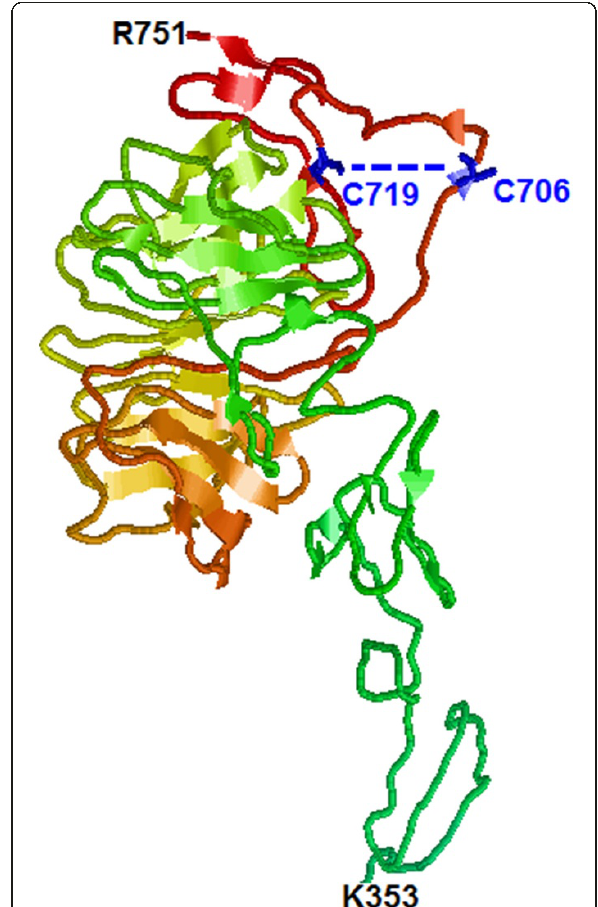
Figure 4 A model of the predicted structure of R353-K751 residues of the human VLDLR. The model was constructed using the Swiss Model program (http://swissmodel.expasy.org) with the full length sequence of the human VLDLR protein. The model has been visualized using RasMol (http://rasmol.org). According to the UniProtKP database, cysteine 706 is predicted to form a disulfide bond with cysteine 719 (Blue colored) (http://www.uniprot.org/